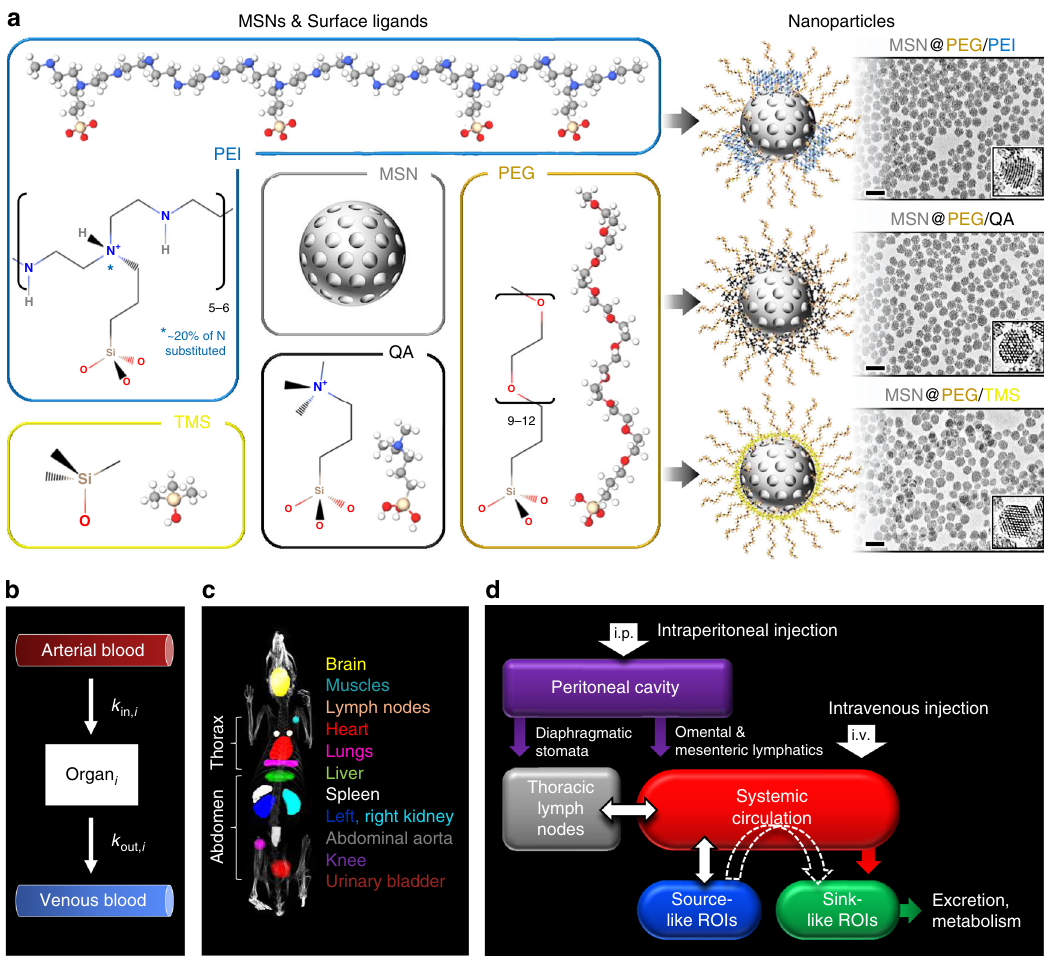
Fig. 1 Design of MSNs, SPECT/CT imaging, and mathematical modeling. a Molecular models of surface ligands and the resulting MSNs used in the study, characterized by TEM. Polyethylenimine (PEI) is “ patchy ” and may extend beyond the polyethylene glycol (PEG) layer and cover the MSN surface intermittently, unlike the smaller quaternary amine (QA) and trimethylsilane (TMS) groups that remain shielded within the PEG layer and cover the MSN surface uniformly. PEI and QA groups provide a strongly positive zeta potential ( ζ ) to MSNs, while TMS makes them neutral. Scale bars: 100 nm. b A schematic of the underlying modeling hypothesis depicts an organ i that receives in fl ux of NPs from its major feeding artery, which after crossing the vasculature of organ i exit into venous blood. Assuming the in fl ux and ef fl ux processes to both follow fi rst-order kinetics with rate constants k in, i and k out, i , respectively, we obtain a double-exponential function (Eq. (4)) to describe the concentration – time course of NPs in individual ROIs. c Regions of interest (ROIs) generated using inviCRO ’ s Multi Atlas Segmentation Tool to perform quanti fi cation of whole-body radioactivity concentration. d Representation of the whole-body framework to understand the disposition of NPs. I.p. administration, unlike i.v. injection, is associated with absorption of NPs from the peritoneal cavity into systemic circulation through bowel lymphatics, causing accumulation of NPs in thoracic lymph nodes. Once in the systemic circulation through either route of injection, NPs are distributed across all organs in the body in proportion to organ blood fl ow rates. Once inside the organ microvasculature, NPs encounter traps that sequester NPs from circulation into the interstitial space. Based on the low or high density of traps, we can classify the organs into “ source-like ” and “ sink-like, ” respectively. The former do not sequester NPs due to lack or low density of traps, unlike the latter, which generally trap NPs unless the physicochemical properties of NPs are unfavorable for entrapment. By allowing NPs to pass through their vasculature without sequestration, source-like organs thus become a secondary source of NPs for the sink-like organs (as depicted through the dotted white arrow), which eventually dispose of the NPs through metabolic and excretory